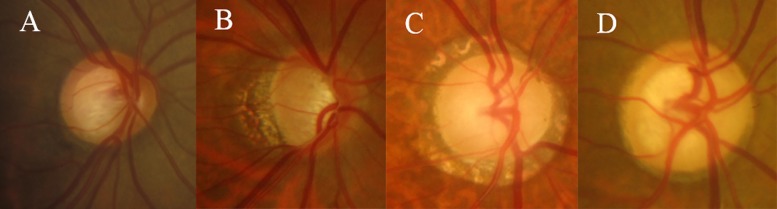
Photographs of four distinct optic disc phenotypes.(a) Focal ischemic optic disc, (b) Myopic optic disc, (c) Senile sclerotic optic disc, (d) Concentric enlarged optic disc.